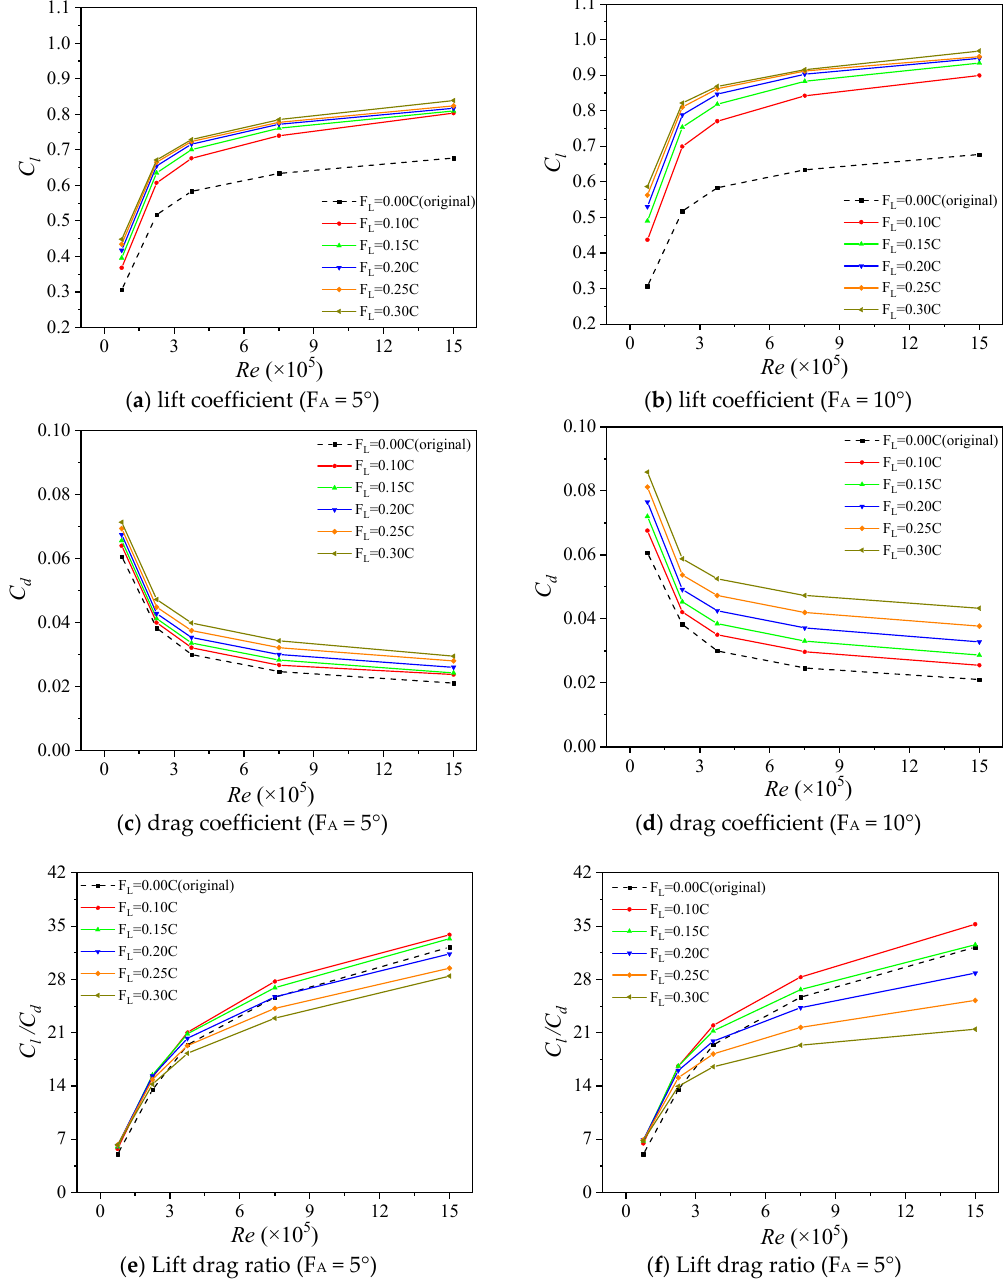
Figure 8. Influence of Re on hydrodynamic performance of hydrofoil (AOA = 6°).